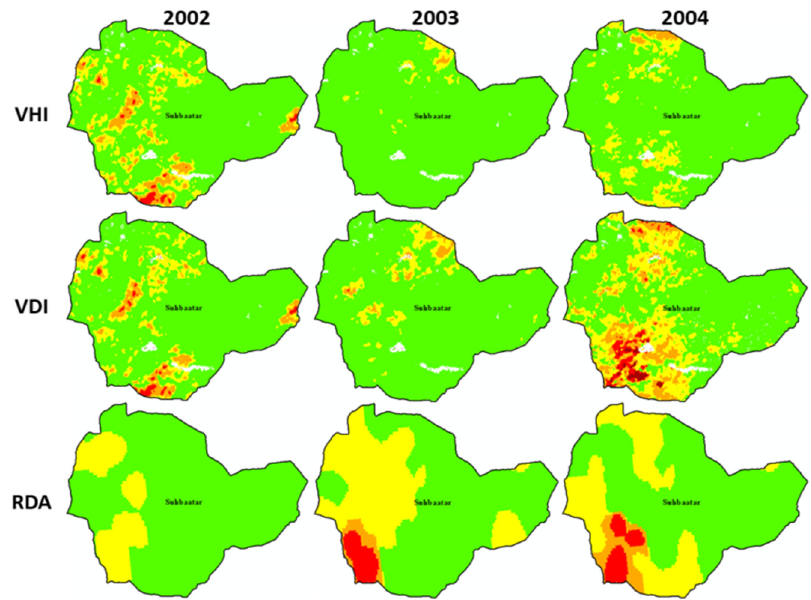
Remote Sens. 2021 , 13 , x FOR PEER REVIEW Figure 5. Drought distribution maps of the VHI, VDI, and field-based RDA in the first dekad of each July Figure 2002 to 2004 for Suhbaatar Province.